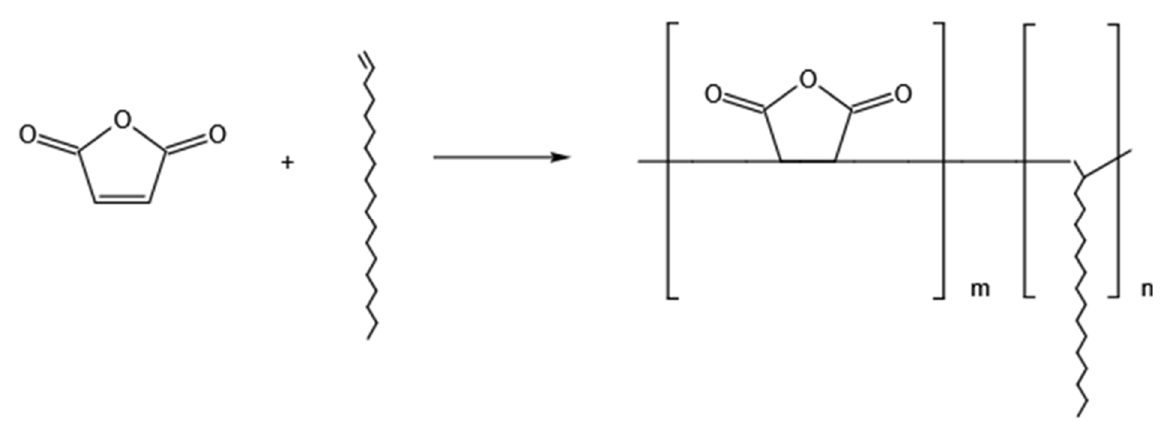
Figure 2. Synthesis of the maleic anhydride- α -octadecene copolymer.